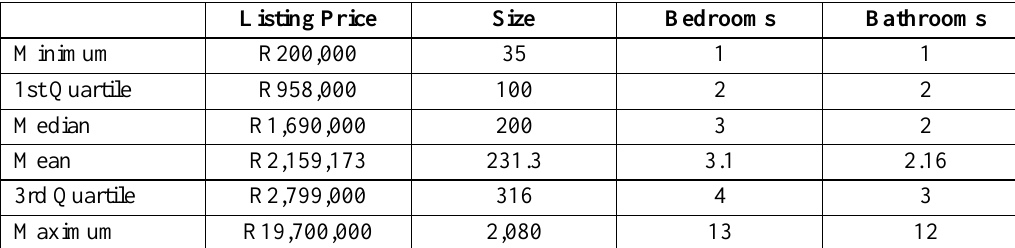
Table 3. Final Data Summary Statistics